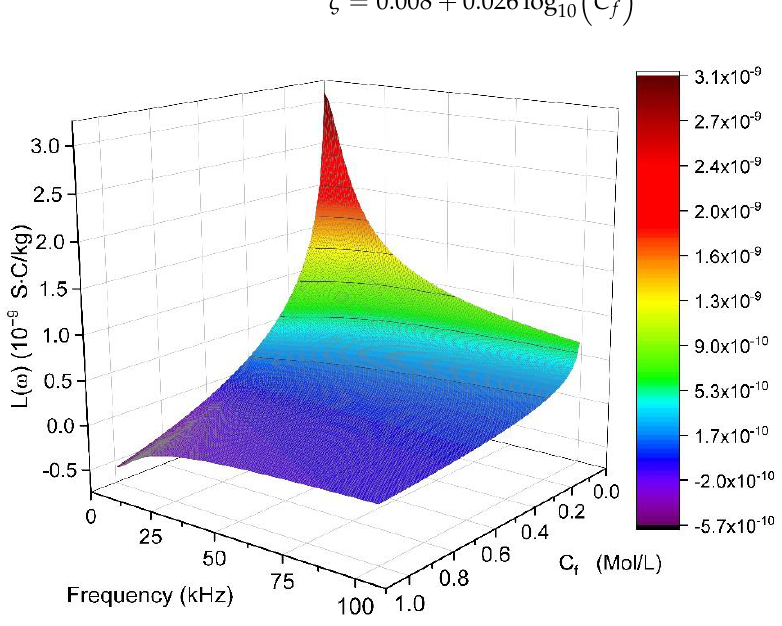
Figure 2. Dependence of electrokinetic coupling on frequency and fluid salinity.